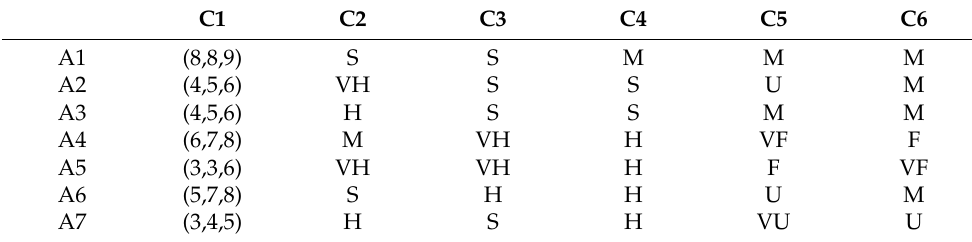
Table 4. Evaluation of alternatives by